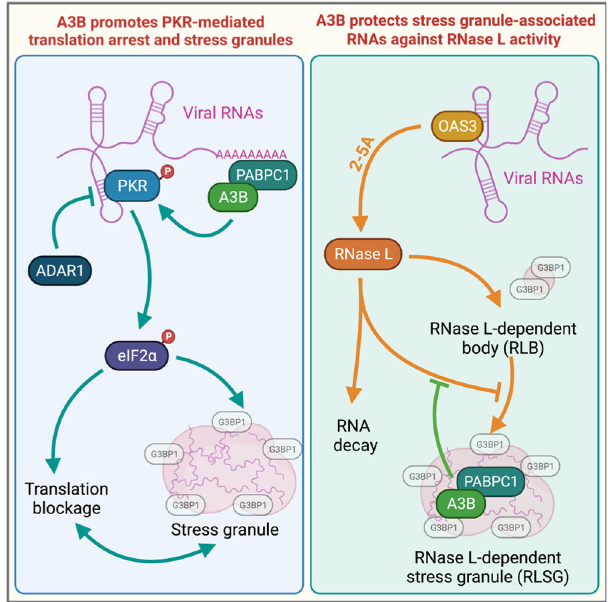
Fig. 10 | A3B drives PKR-mediated translation arrest and protects stress granulesagainstRNaseLactivity. A3BformsacomplexwithPABPC1tostimulate PKR and counterbalances the PKR-suppressing activity of ADAR1 in response to viral infection. Furthermore, A3B localizes to stress granules through the interac- tion with PABPC1 to protect mRNA associated with stress granules from RNAse L-induced RNA cleavage during viral